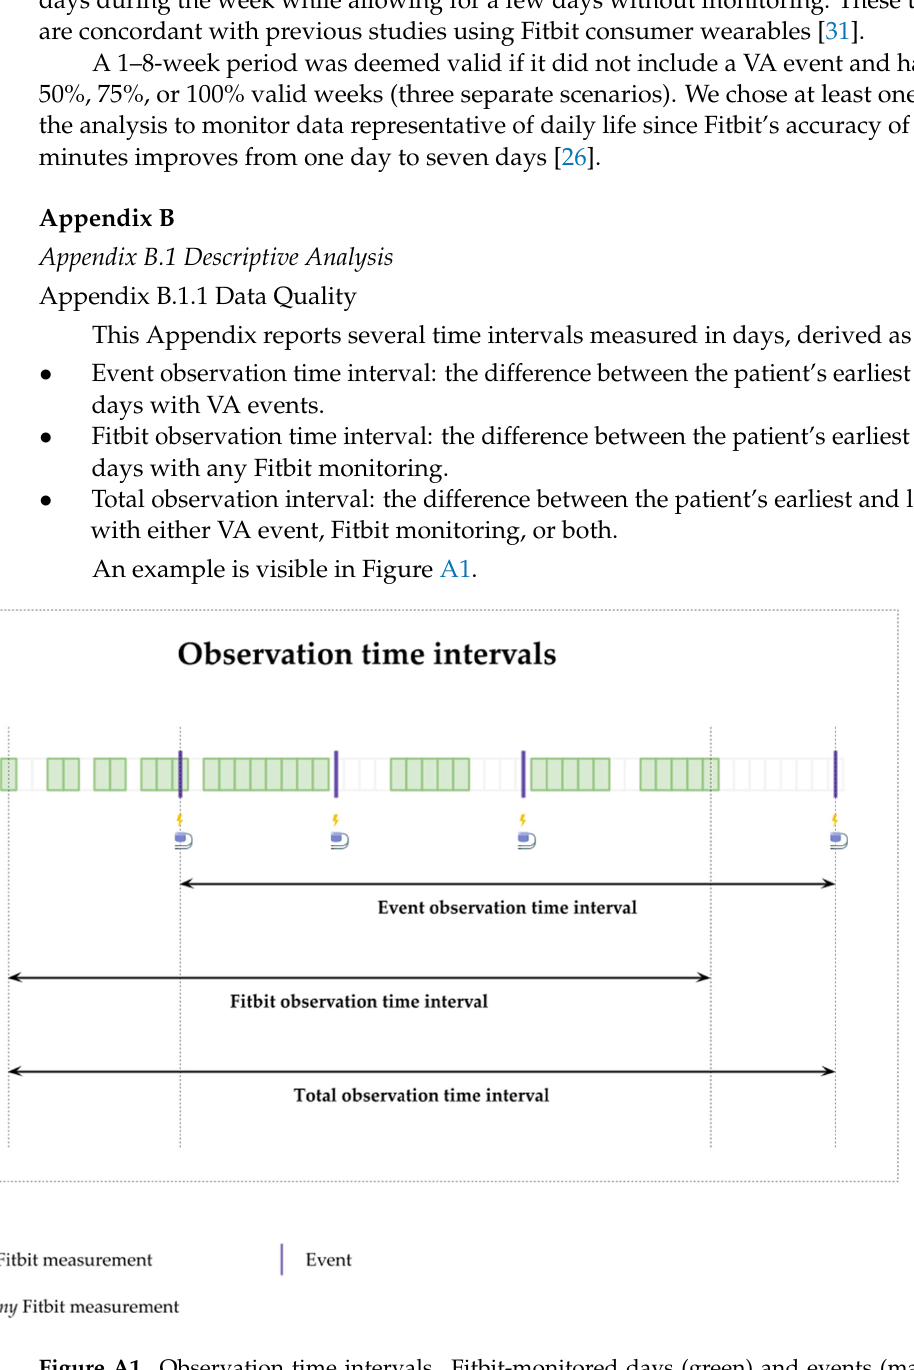
Figure A1. Observation time intervals. Fitbit-monitored days (green) and events (magenta) are depicted on a timeline. The first and last event days delimit the event observation time interval. The first and last Fitbit monitoring days delimit the Fitbit observation time interval. The first event or first Fitbit-monitored day (whichever occurs first) and the last event or last Fitbit-monitored day (whichever occurs last) delimit the total observation time interval.